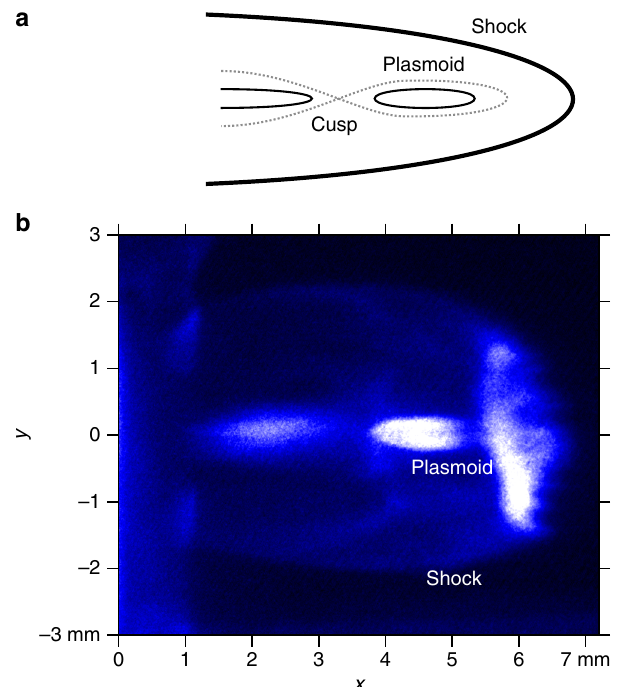
Fig. 3 Two dimensional snapshot of cusp and plasmoid. a Schematic view of a magnetic reconnection. b Image of self-emission obtained with gated charge coupled devise (CCD) camera at 35 ns after the main laser shot. The